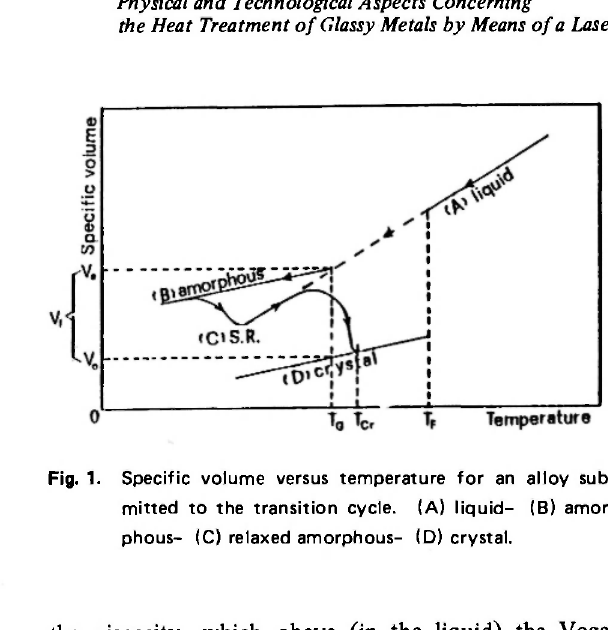
Fig. 1. Specific volume versus temperature for an alloy sub- mitted to the transition cycle. (A) liquid- (B) amor- phous- (C) relaxed amorphous- (D) crystal.